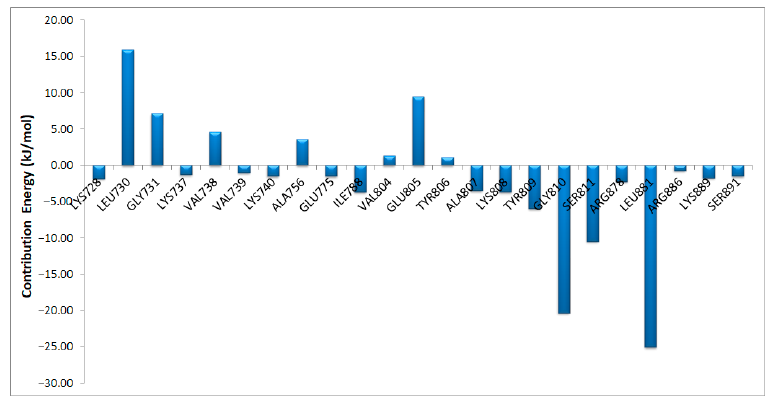
Figure 4. The column chart depicting the each residue contribution in the total binding free